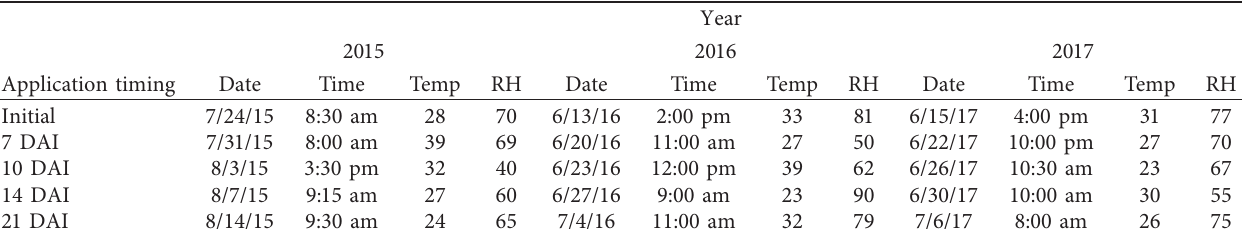
Table 1: Weed heights and densities for three species at the time of the initial herbicide application in 2015, 2016, and 2017. Species Barnyardgrass Broadleaf signalgrass Table 2: Dates of herbicide applications in 2015, 2016, and 2017 and weather conditions at the time of application at Fayetteville, AR.